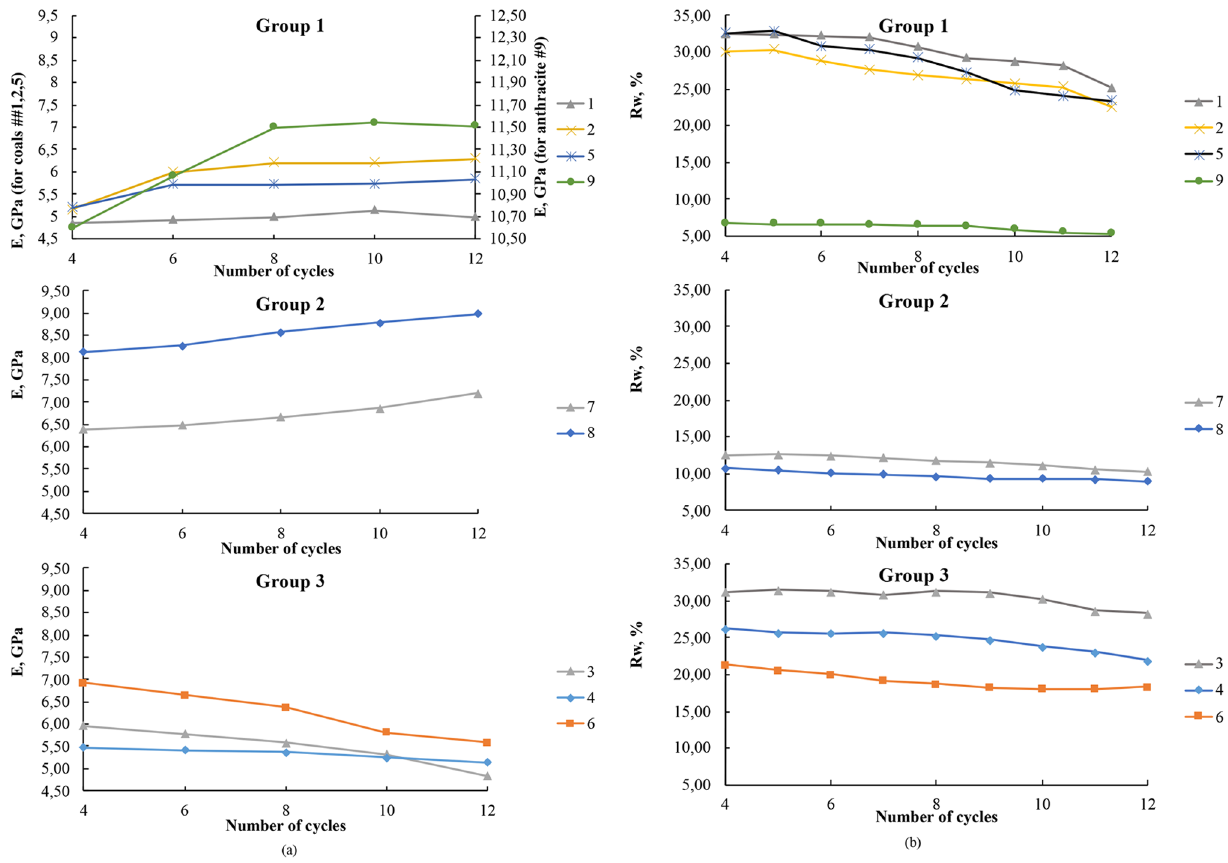
Fig. 3 Changes in a Elastic moduli and b Damage index for coals at cyclic nanoindentation: a division into